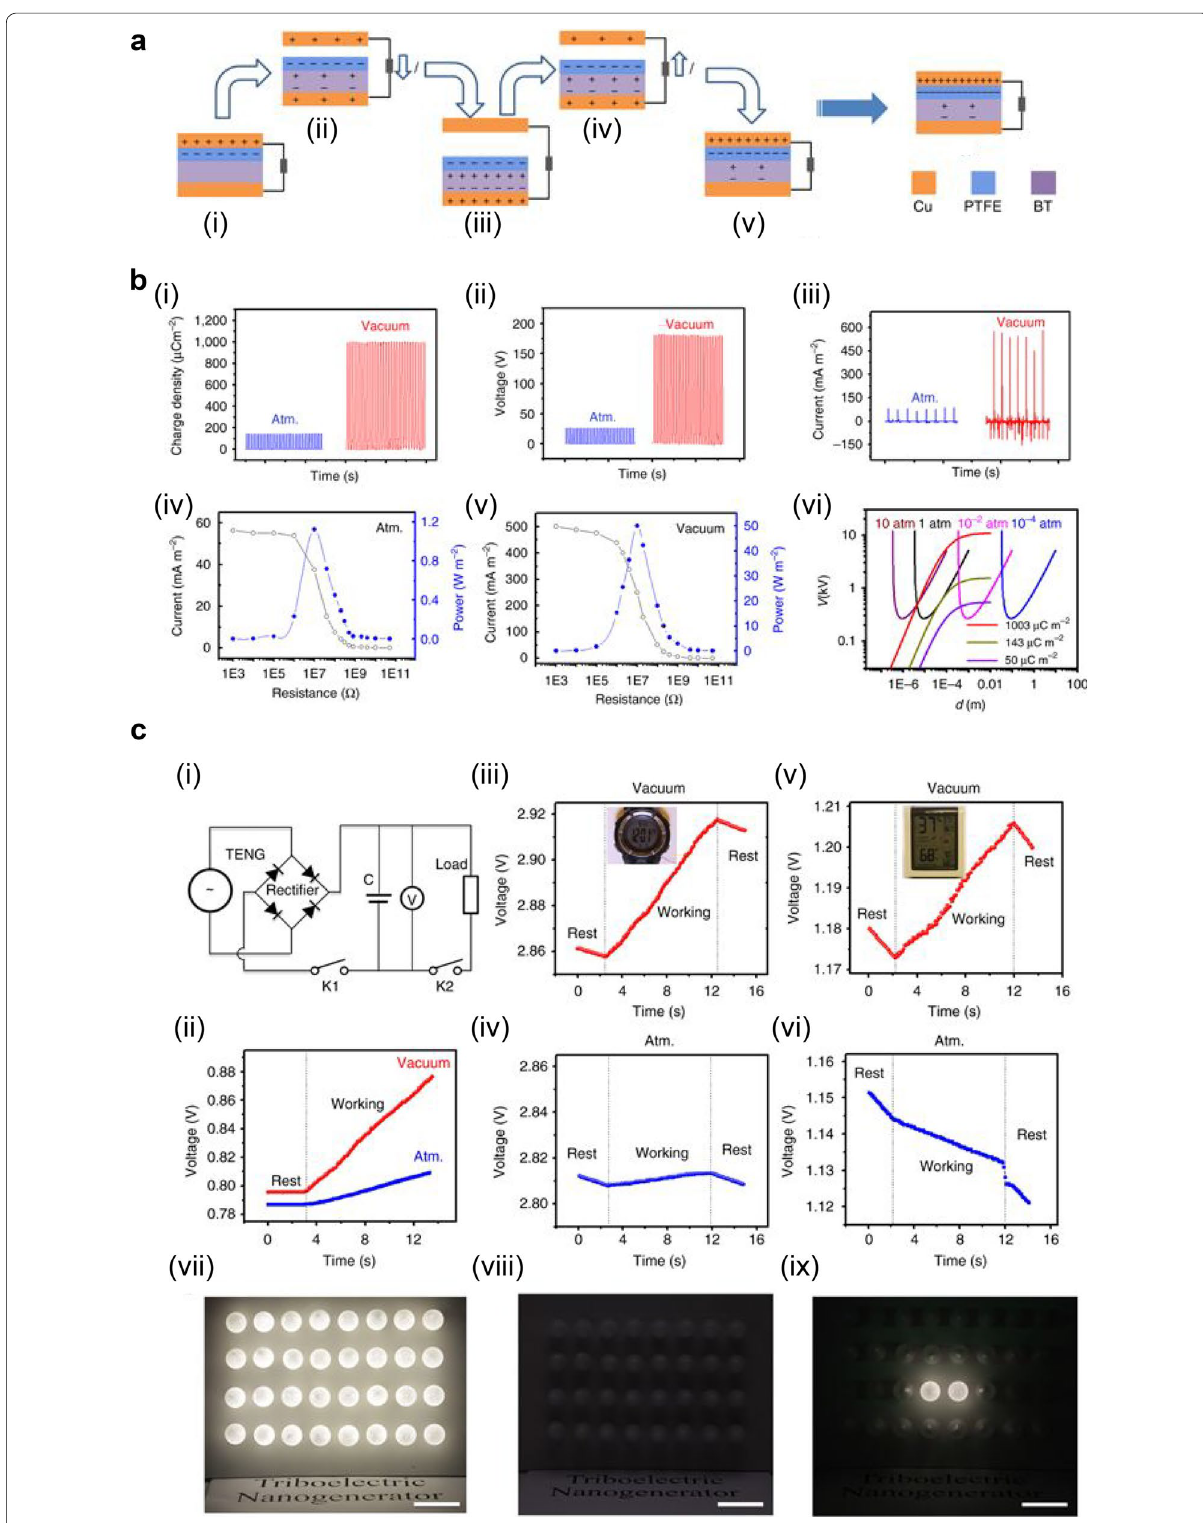
Fig. 6 a Schematic structure and working sequence of TENG with ferroelectric polarization. b Output performance of TENG in atmosphere and high vacuum. c Charging supercapacitor while working electronics simultaneously, and powering LEDs (Reproduced from [43] with copyright permission from 2017 Nature Publishing